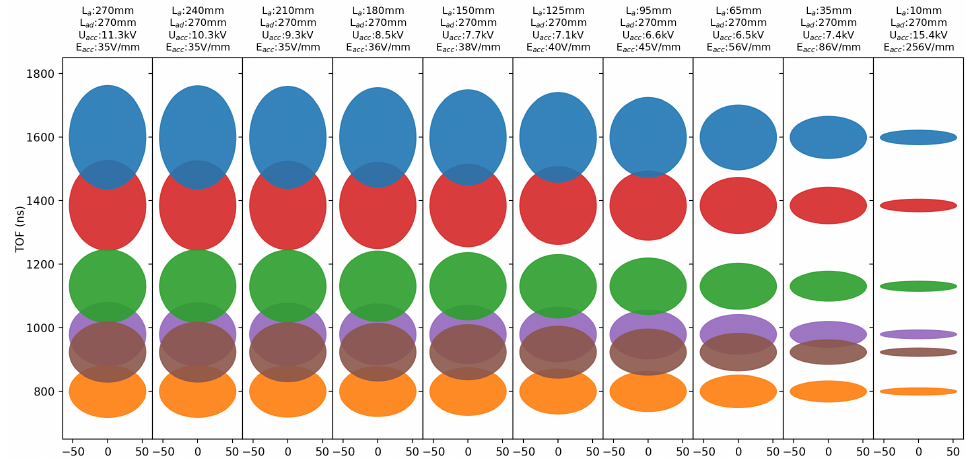
Figure 9. Simulated “TOF vs. R” plots, with L ad fixed at 270 mm, and L a varying from 270 mm to 10 mm. The values of the acceleration length L a , acceleration-plus-drift length L ad , the voltage change across the spectrometer U acc , and the resulting electric field E acc are placed on top of their corresponding